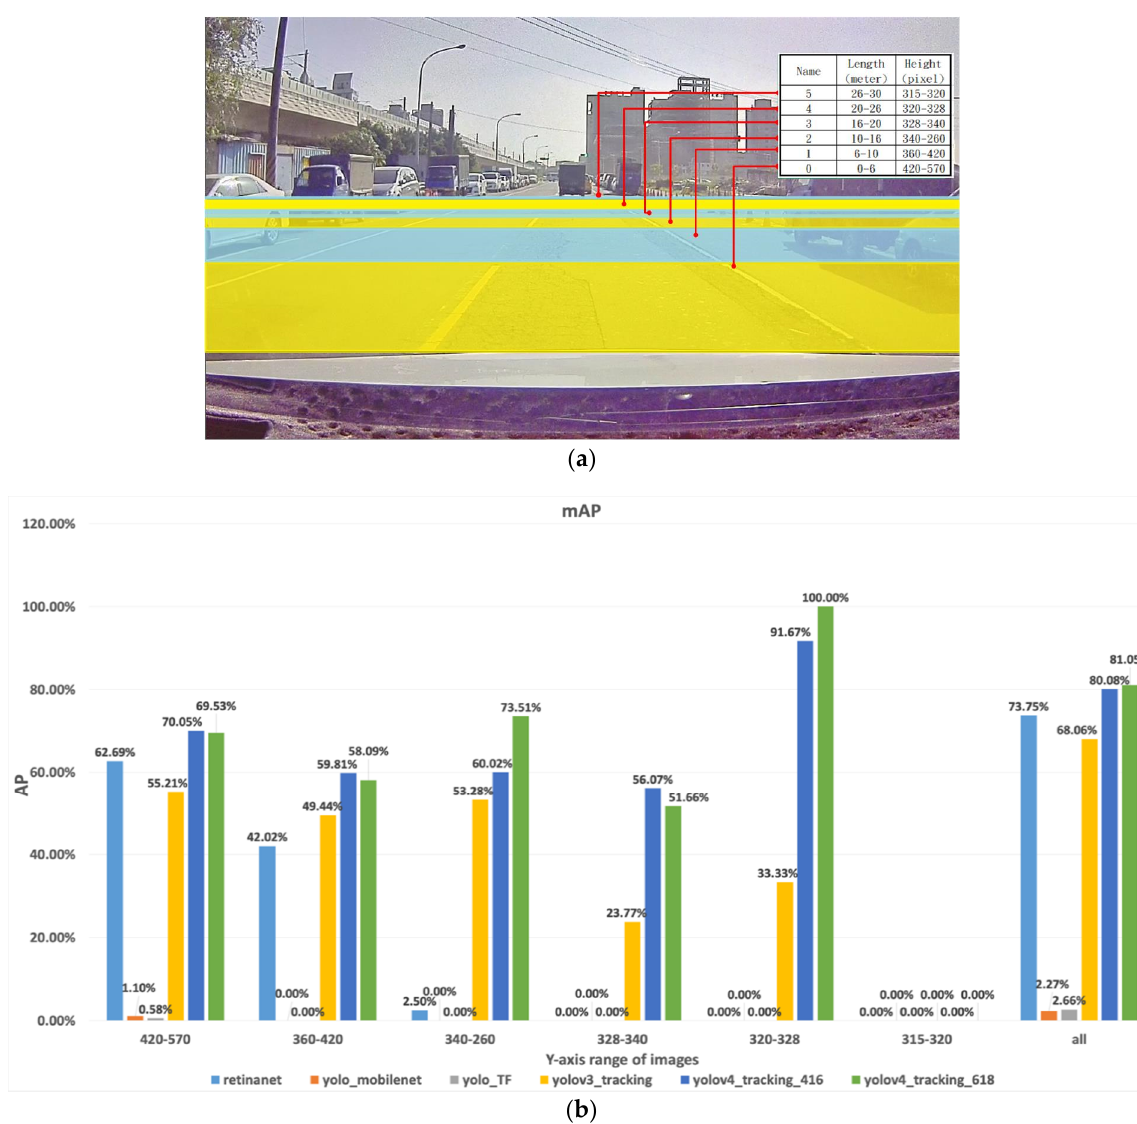
Figure 15. Quantitative comparison of AP of pothole category for each model in different distance intervals. ( a ) Relationship between the pixel differences to actual road distance; ( b ) AP evaluation results for each model in different distance intervals.